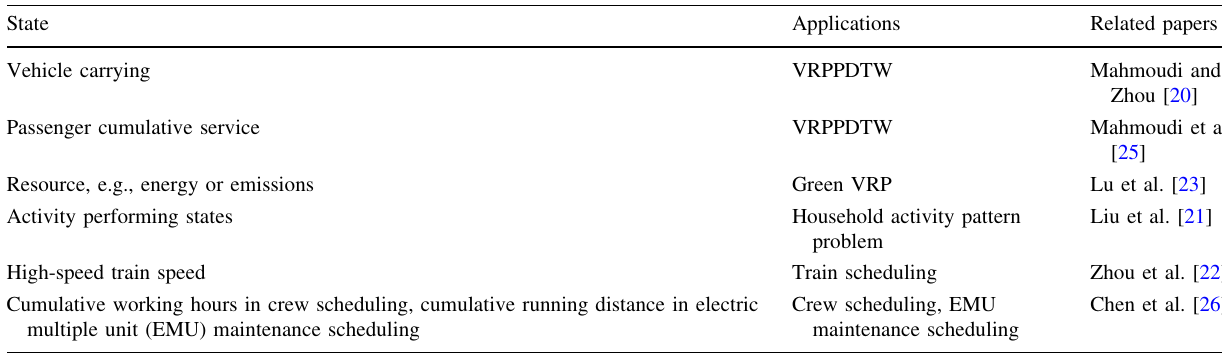
Table 2 Typical different state representations